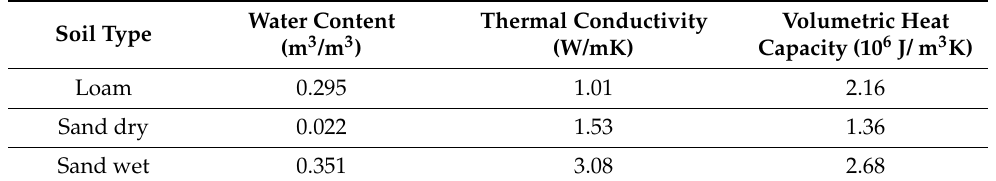
Table 1. Soil properties [10].